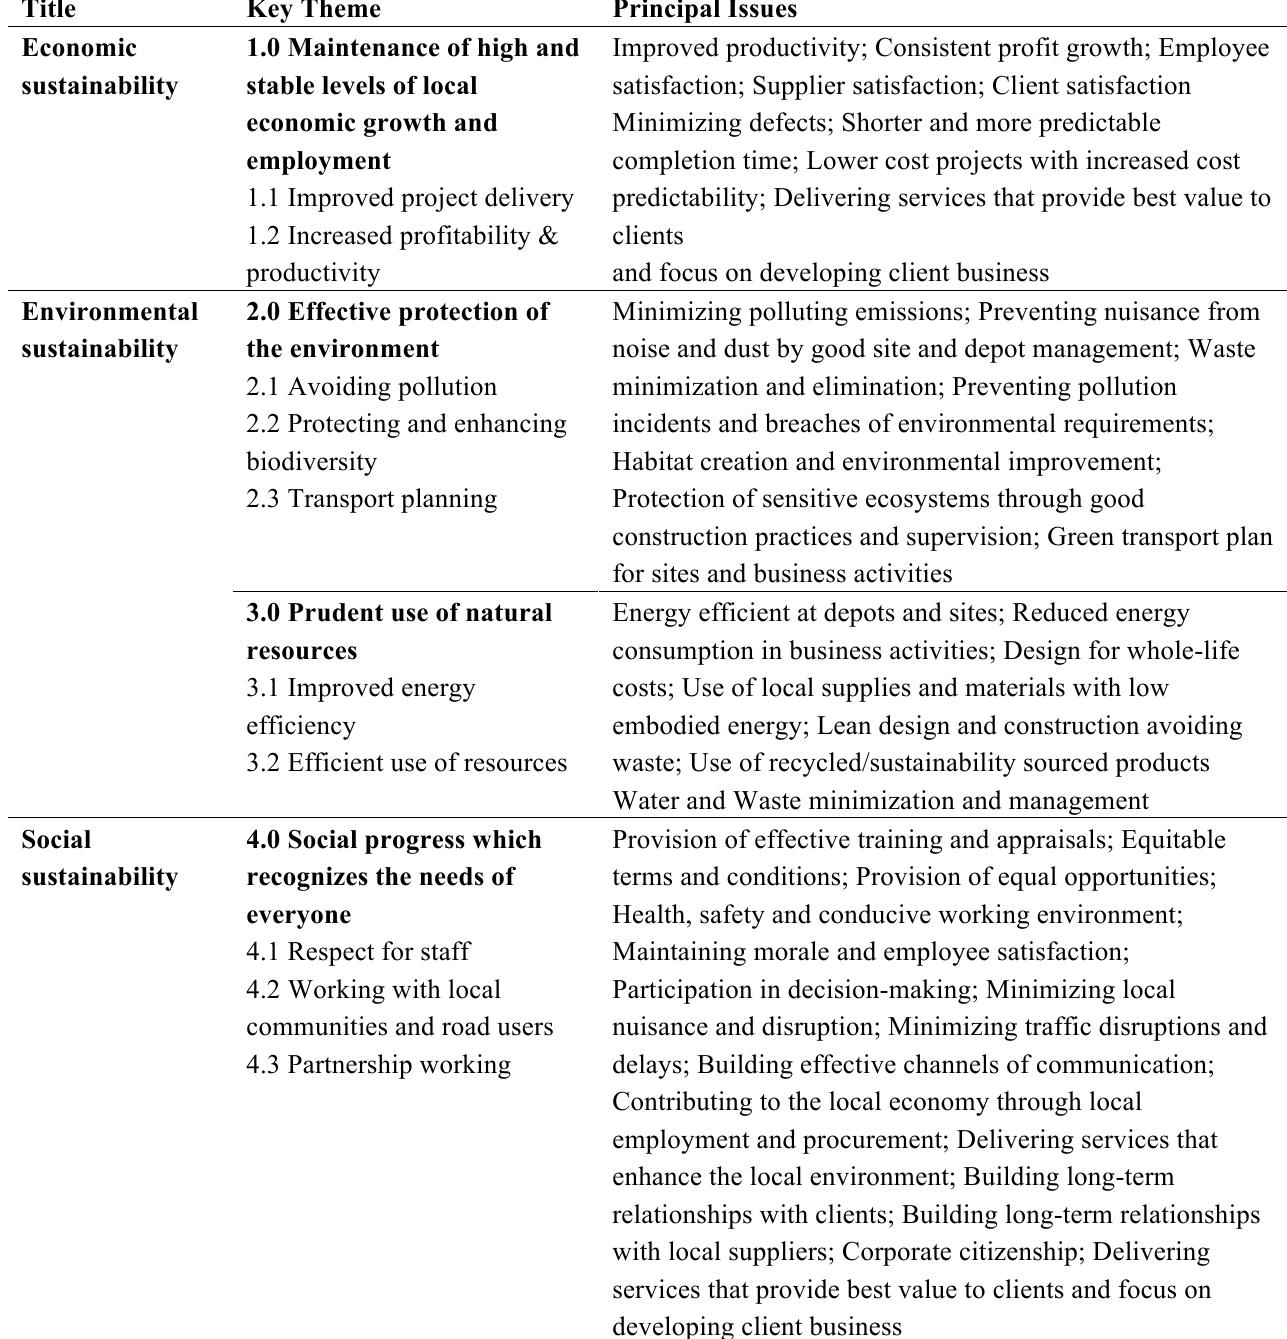
Table 1. Sustainable building